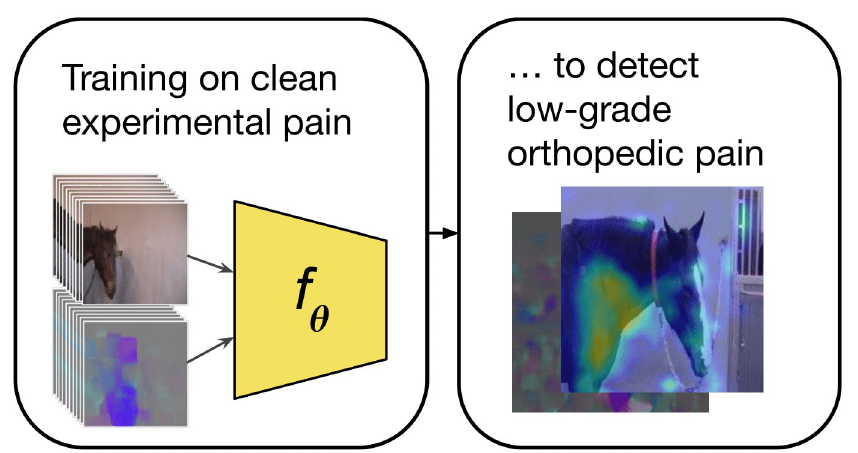
Fig 1. We present a study of domain transfer in the context of different types of pain in horses. Horses with low grade orthopedic pain only show sporadic visual signs of pain, and these signs may overlap with spontaneous expressions of the non-pain class—it is therefore difficult to train a system solely on this data.